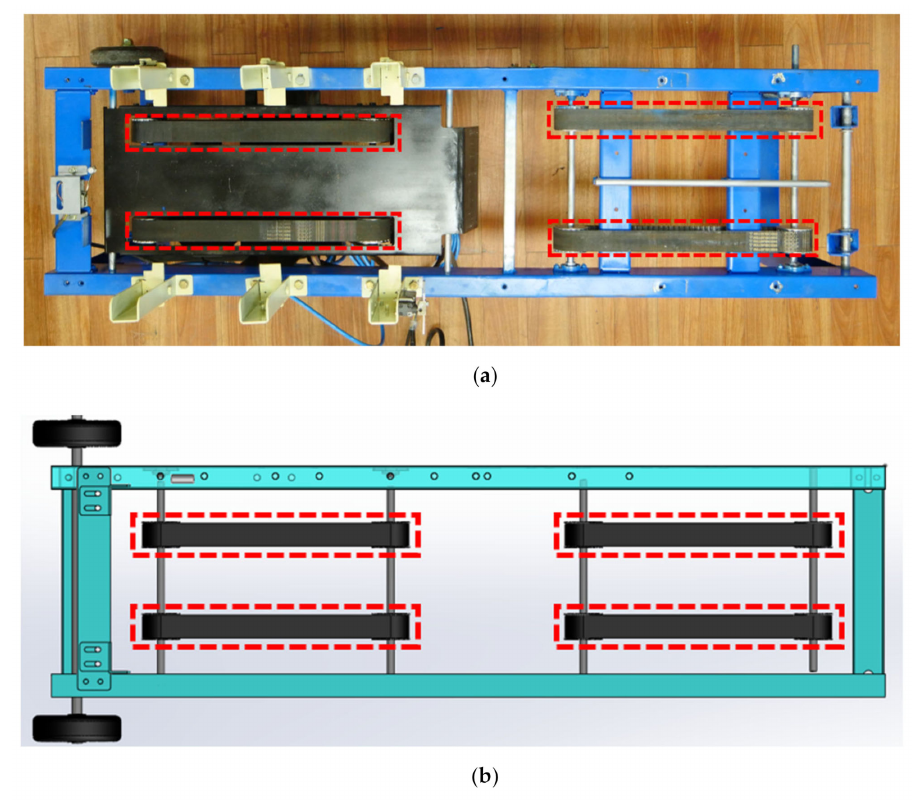
Figure 2. Shape of conveyor belt: ( a ) picture and ( b ) 3D